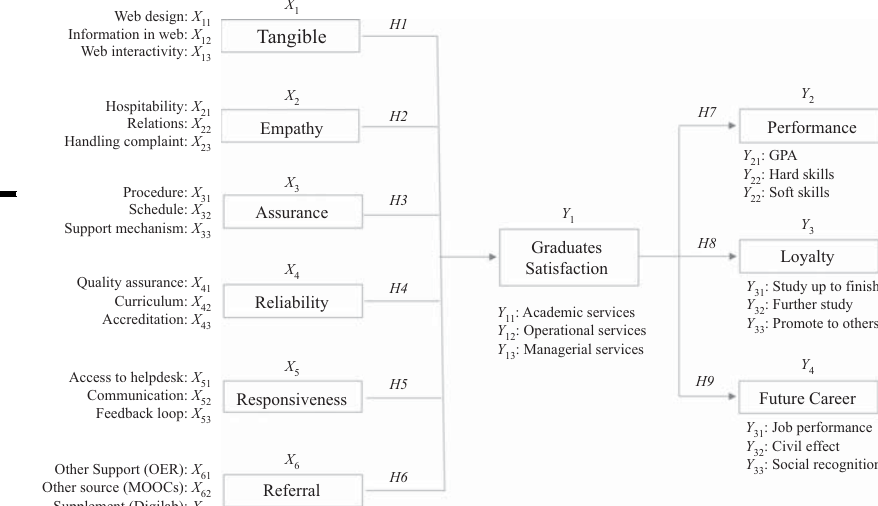
Figure 2. The operational framework of the